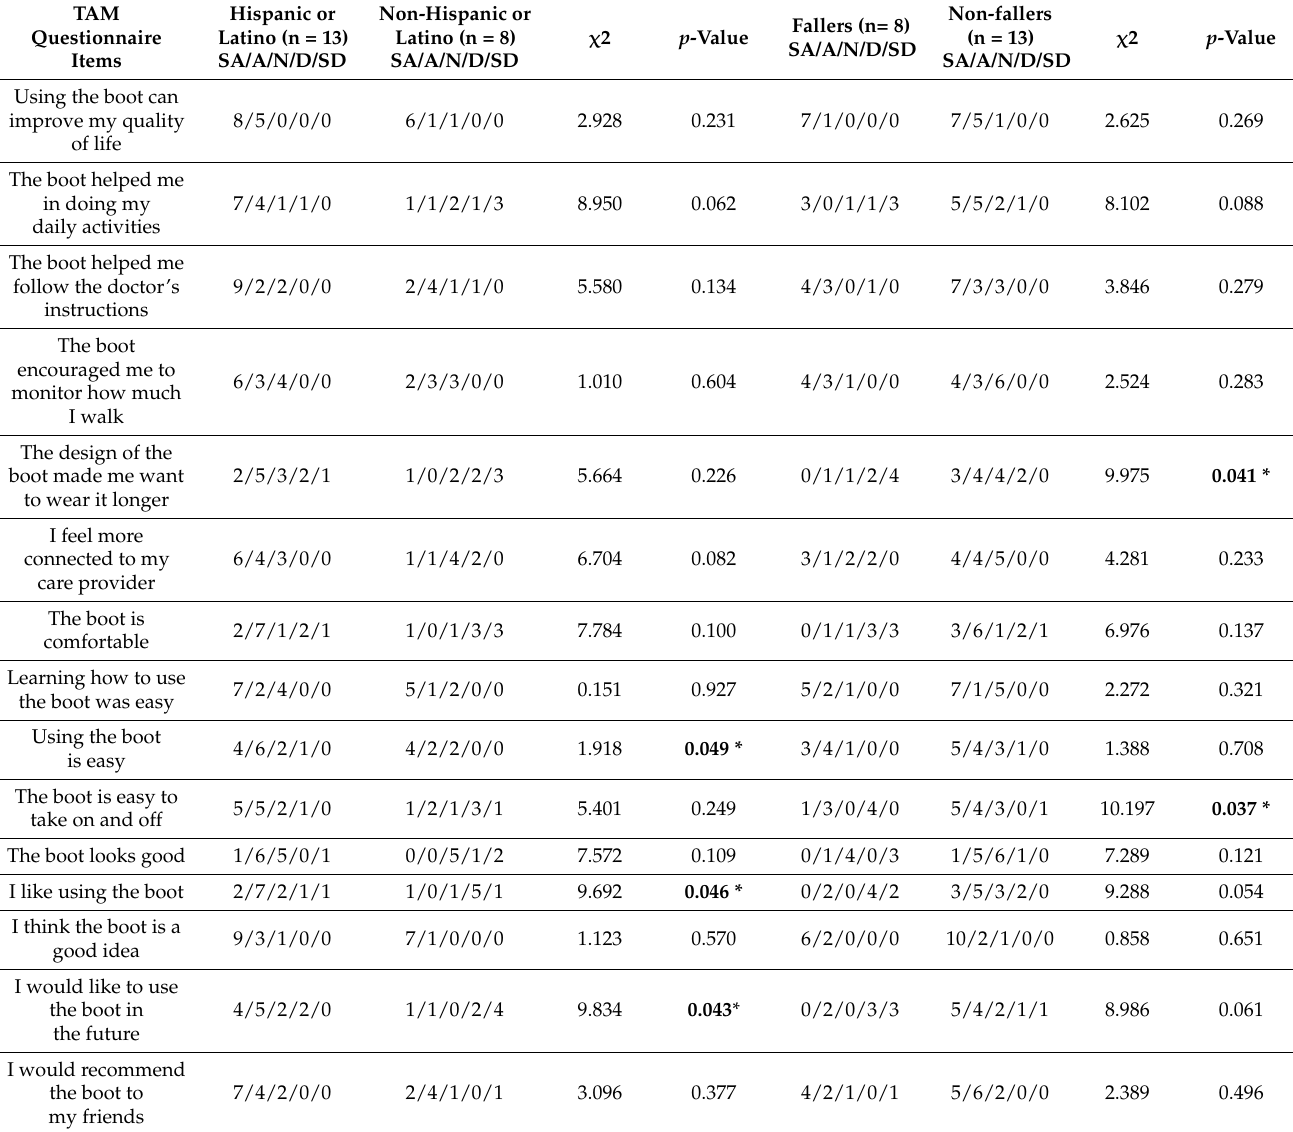
Table 2: Rating counts of participants who selected strongly agree (SA)/agree (A)/neutral (N)/disagree (D)/strongly disagree (SD) on the Technology Acceptance Model (TAM) questionnaire items. Chi-squared tests of independence were performed to assess significant differences between ethnicity (Hispanic or Latino, Non-Hispanic or Latino) and fall status (fallers, non-fallers). Chi-squared values ( χ 2) are depicted. 2-sided p -values of p ≤ 0.05 were considered significant. Bolded p -values with asterisks (*) denote